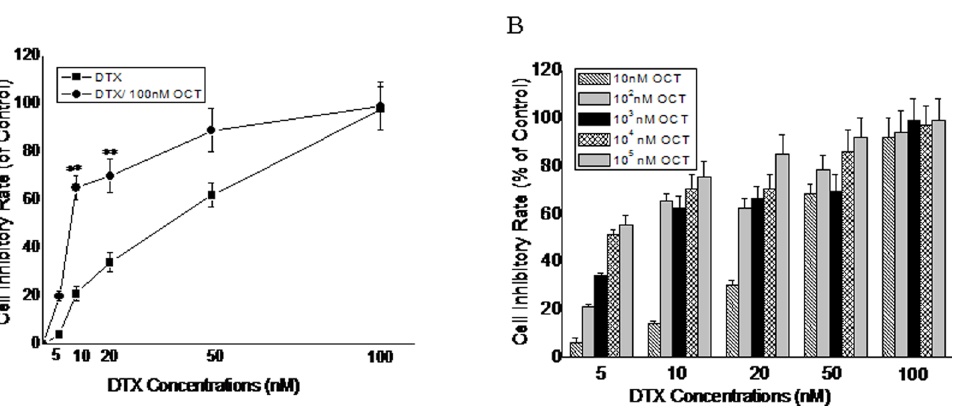
Figure 3. Effect of DTX alone, synergistic effect of DTX in combination with 100 nM OCT (Fig. 3A) and various concentrations of two agents (Fig. 3B) on DU145 cells proliferation following 72 h of treatment. Results are the percentage of control value obtained with untreated cells (mean 6 SEM of three experiments done in triplicate). (**) Proliferation was significantly decreased ( p , 0.001); error bars=SEM.